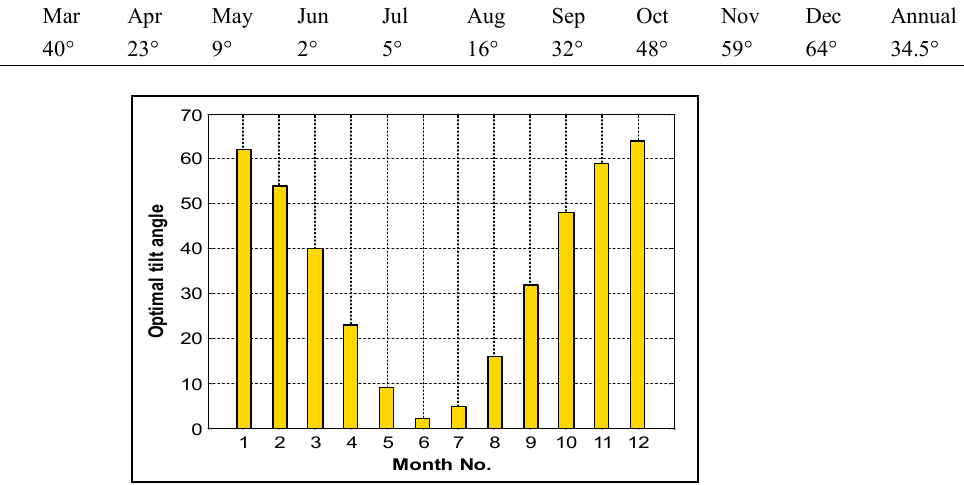
Figure 14. Monthly optimal tilt angle using MATLAB for California.